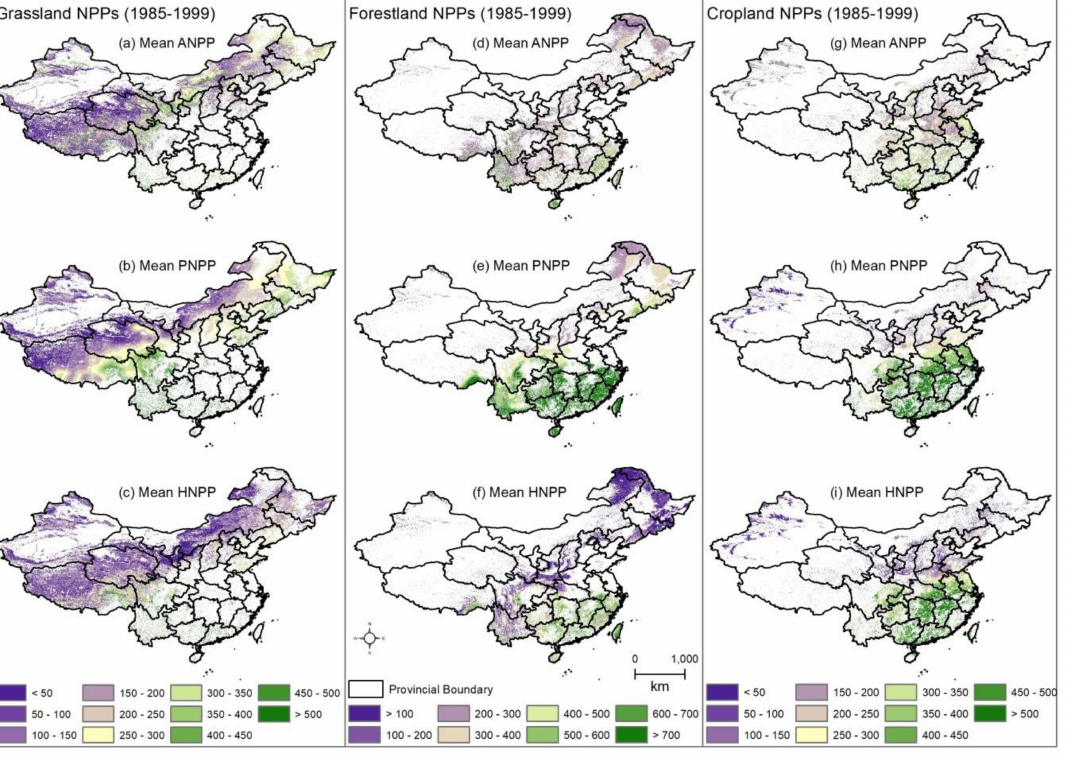
Figure 6. Mean actual net primary productivity (ANPP), mean potential NPP (PNPP), and mean human-induced NPP (HNPP) for the base period: ( a – c ) the mean ANPP, PNPP, and HNPP for grassland, respectively; ( d – f ) the mean ANPP, PNPP, and HNPP for forestland, respectively; ( g – i ) the mean ANPP, PNPP, and HNPP for cropland,